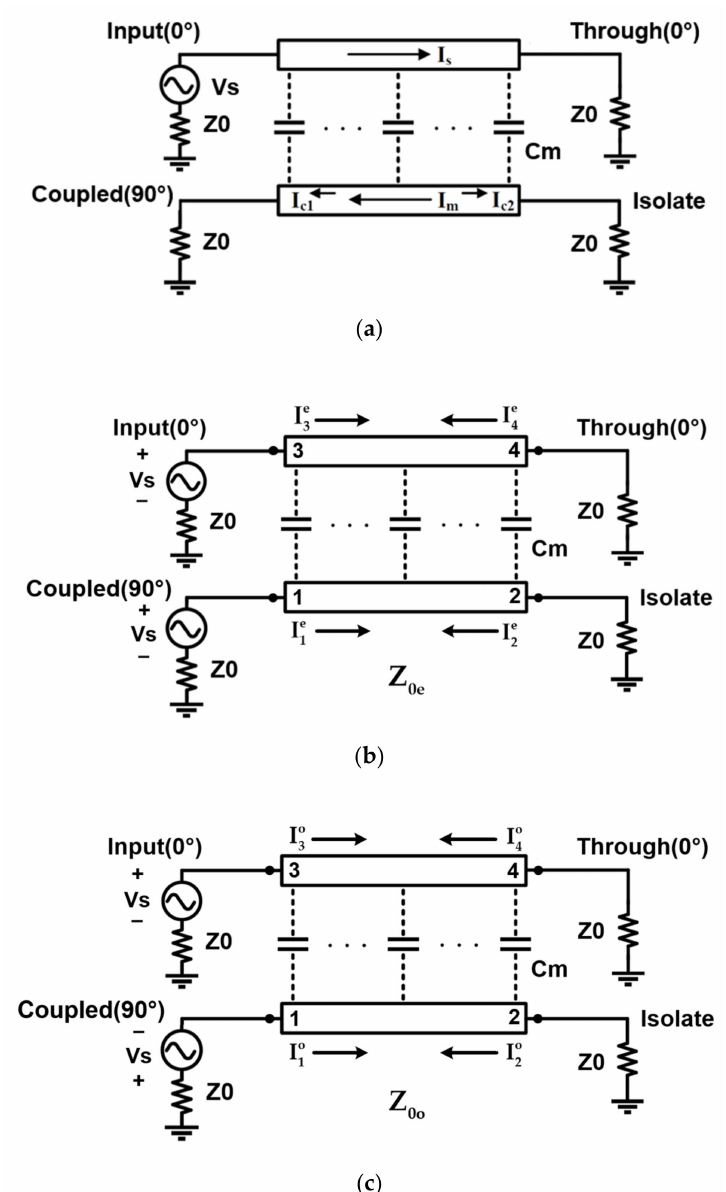
Figure 3. ( a ) Schematic representation of the transmission line quadrature hybrid, as well as its ( b ) even-mode circuit and ( c ) odd-mode